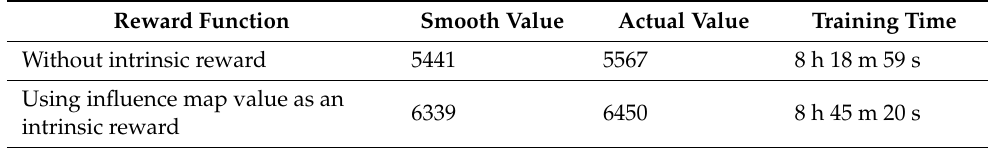
Figure 9. Comparison of the training scores before and after the use of the influence value as an intrinsic reward. intrinsic reward. Table 9. Ordinate comparison of two training scores at 1.2 M gradient